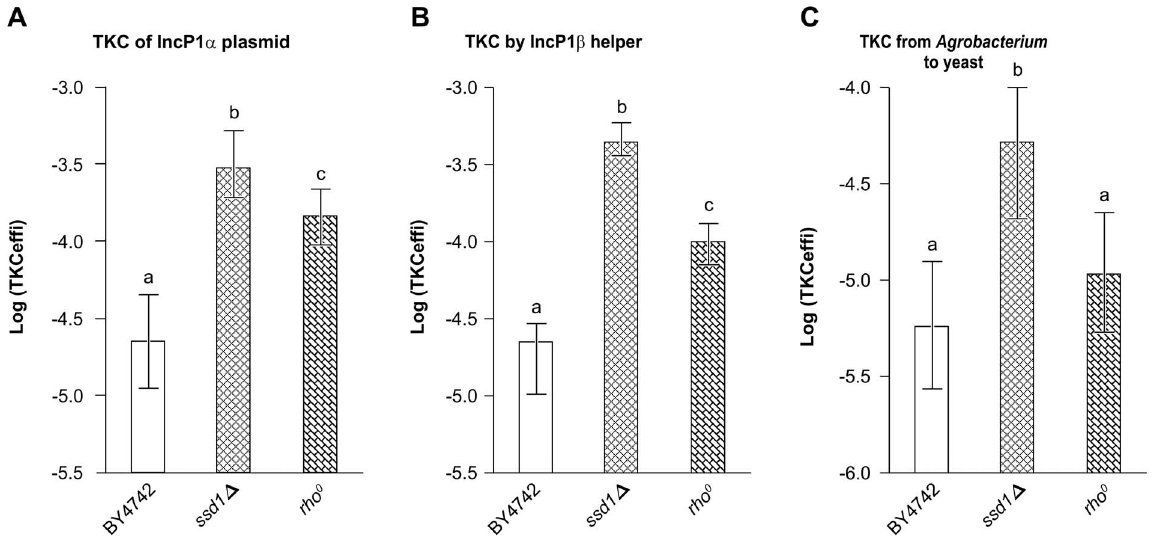
Figure 5. Universality of components comprising TKC between a bacterial strain and a high-DNA-receptivity yeast mutant strain. Efficiency if DNA transfer was measured in the parental yeast strain or its high-receptivity mutants, SSD1 deletion mutant ( ssd1 D ), and rho 0 mutant, after TKC with Escherichia coli HB101 (pRH220, pRS316:: oriT P ) carrying T4SS functions on IncP1 a (A), or with Escherichia coli HB101 (pDPT51, pAY205) carrying T4SS functions on IncP1 b plasmid (B), or with A. tumefaciens C58C1 (RP4, pYN402) (C). Data are represented as mean 6 SD (n=9 in A and C, n=15 in B). Letters above the bars indicate significant differences at p , 0.01 in A, 0.001 in B, and 0.001 in C (Holm’s test).